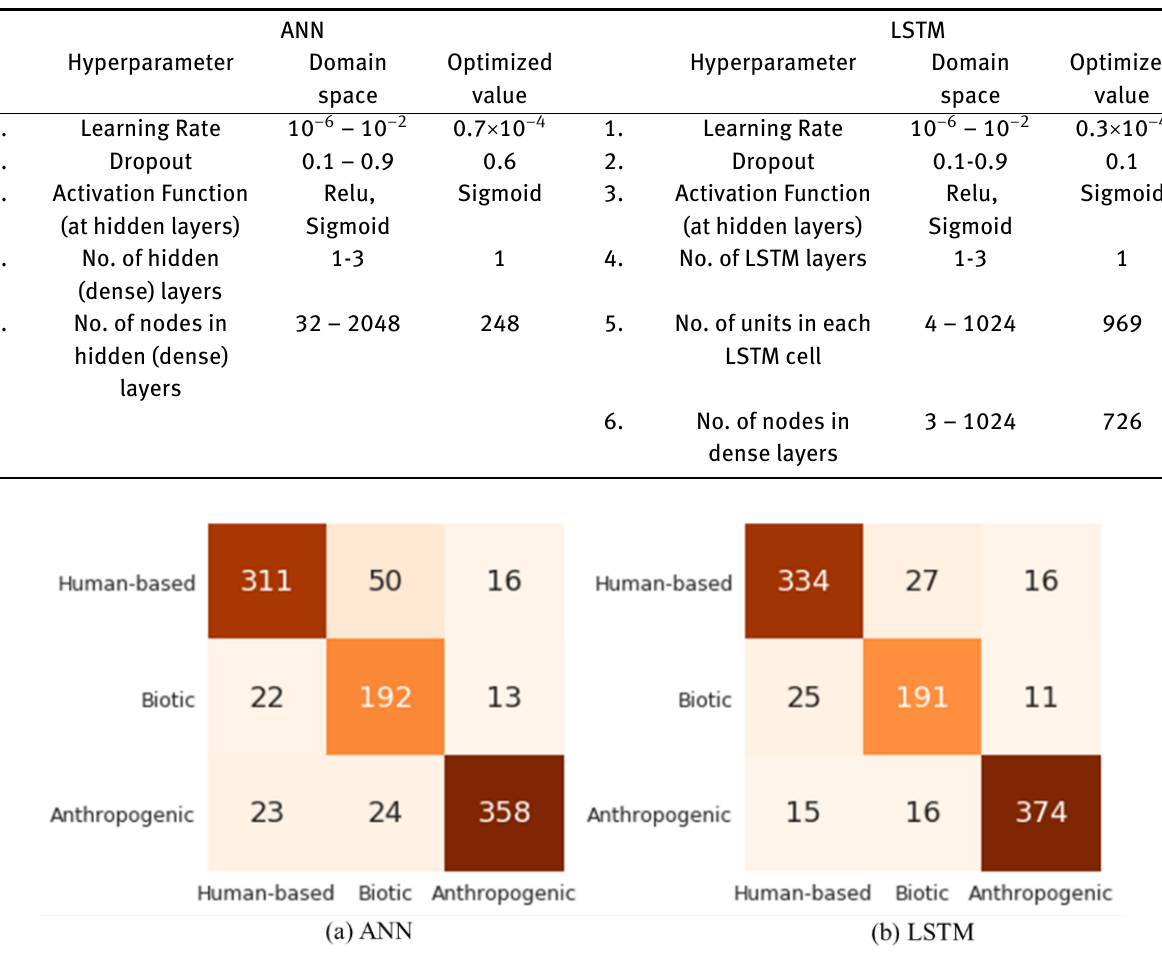
Figure 3: Confusion matrix showing the classification results of 3-class (a) ANN and (b) LSTM models